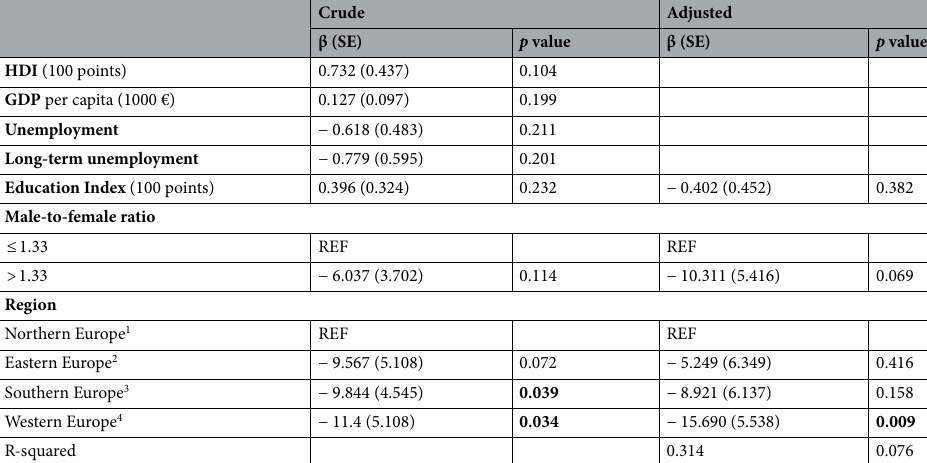
Table 4. Crude and adjusted multivariate linear regression models examining the association between SES indicators and the overall Tobacco Control Scale (TCS) score of 2016 in 31 European countries. The crude linear regression model shows the results of a simple linear regression model of the dependent variable and the independent variable. HDI and Unemployment were excluded due to collinearity with the Education Index and Long-term unemployment, respectively. The adjusted multivariable regression model assessed the effect of SES indicators (Education Index) adjusted for male-to-female ratio and geographical region. We performed the adjusted analysis with the model with the optimal AIC values and fulfilled all regression validation tests. Male-to-female ratio is presented as a binary variable after categorizing countries using the median value (1.33) as cutting point as it fitted better the linear regression model. HDI: Human Development Index; GDP: Gross Domestic Product. 1: Denmark, Estonia, Finland, Iceland, Ireland, Latvia, Lithuania, Norway, Sweden, United Kingdom; 2: Bulgaria, Czech Rep., Hungary, Poland, Romania, Slovakia; 3: Croatia, Cyprus, Greece, Italy, Malta, Portugal, Slovenia, Spain, Turkey; 4: Austria, Belgium, France, Germany, Luxembourg, and the Netherlands. SE: Standard